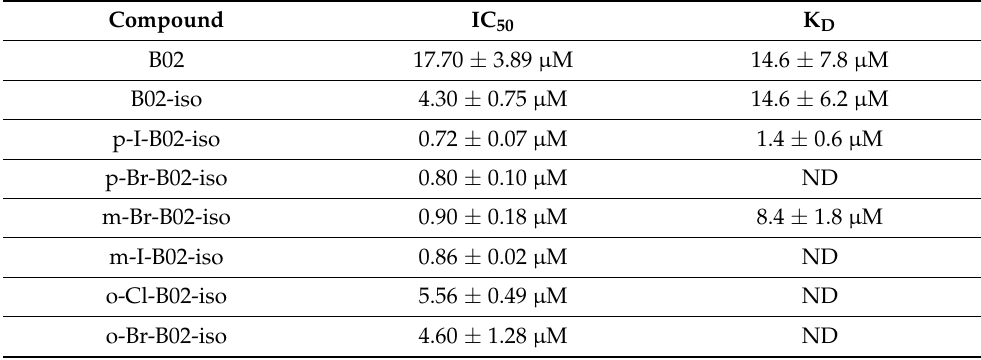
Table 1. Comparison of the potency of RAD51 inhibitors.